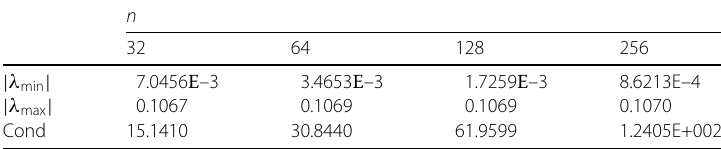
Table 4 The condition number with k =